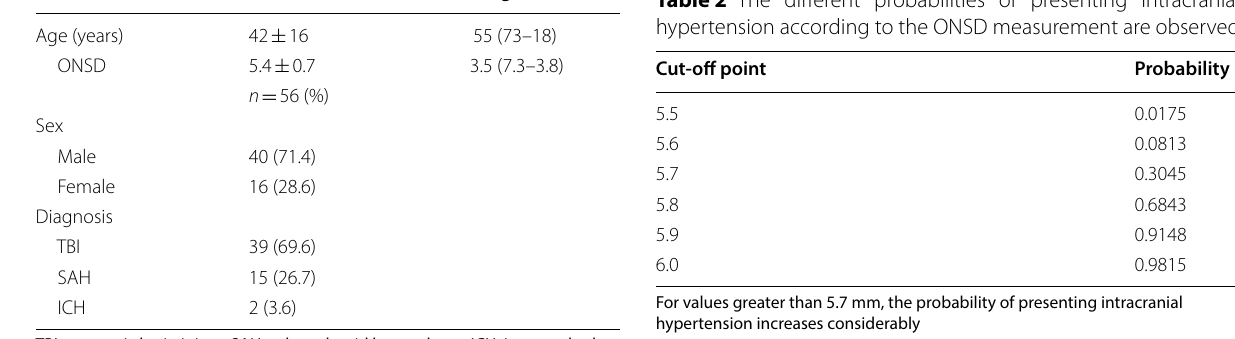
TBI, traumatic brain injury; SAH, subarachnoid hemorrhage; ICH, intracerebral hemorrhage